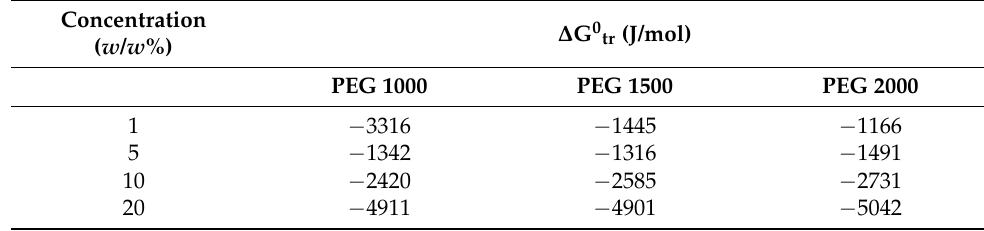
Figure 1. Phase solubility diagram of ketoprofen in hydrochloric acid media at 37 °C in the presence of different PEGs. Data expressed as mean ± SD, n = 3. Table 3. Gibbs free energy values of ketoprofen and the tested PEGs.